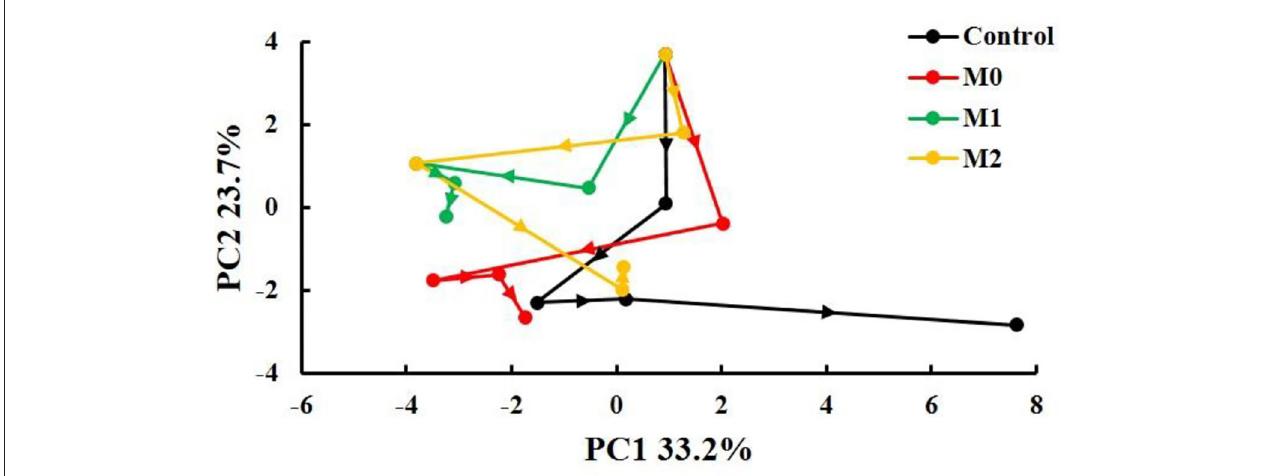
FIGURE 6 | Time-related trajectory plot showing the dynamic time-related responses of sensory and nutritional qualities of different baby mustard lateral buds during storage at 4 ◦ C under different MAP treatments. M0 indicates packaging with no holes; M1 indicates packaging with 6mm in diameter holes; M2 indicates packaging with 12mm in diameter